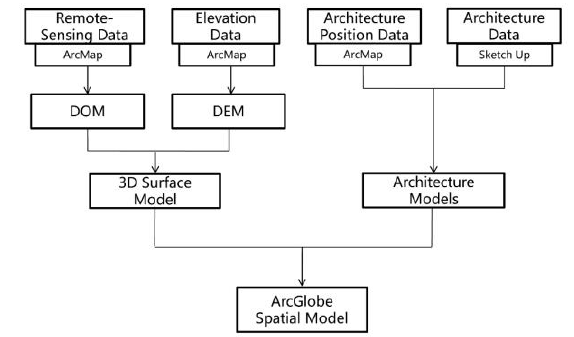
Figure 2. The process of building digital landscape model